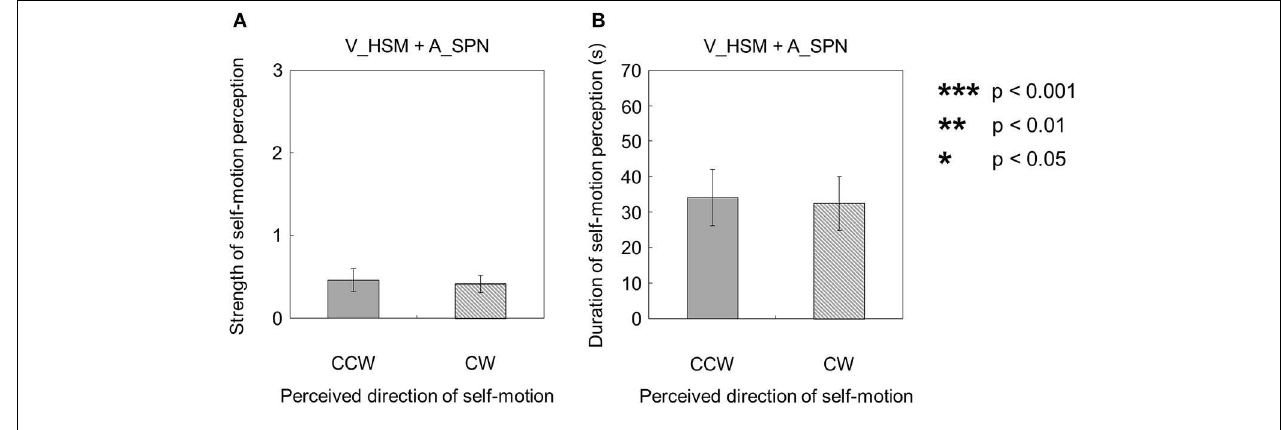
pink noise (A_SPN). The values are plotted by clockwise (CW) and counterclockwise (CCW) directions. The error bars represent standard error (SE).